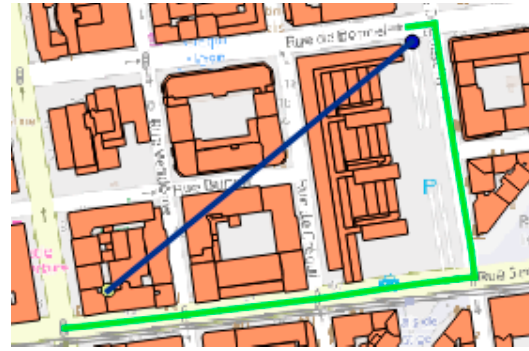
Figure 4. Euclidian distance vs routable road distance.